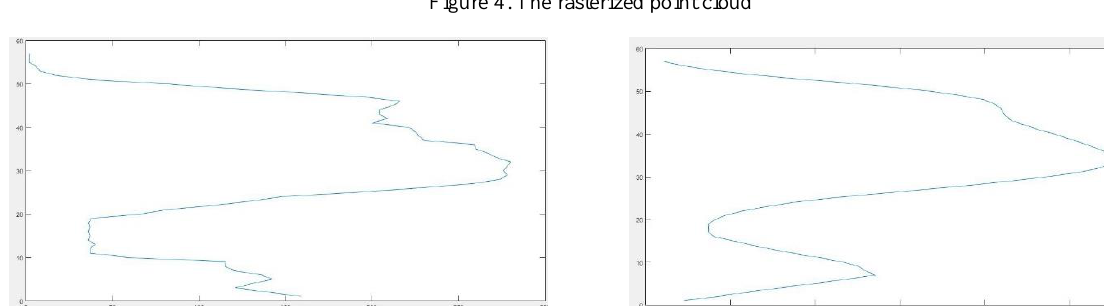
Figure 4. The rasterized point cloud